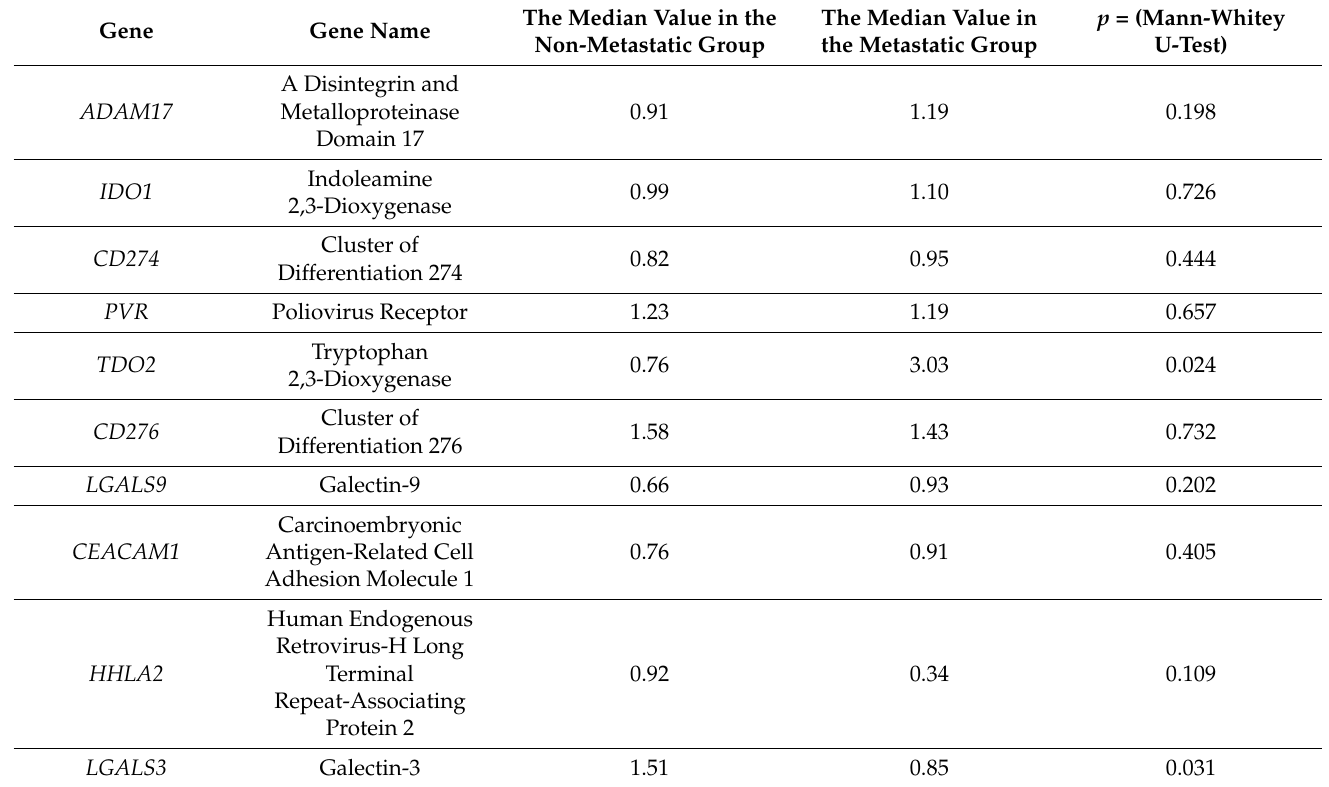
Table 1. The medians of expression and significance of their differences in GC samples with and without